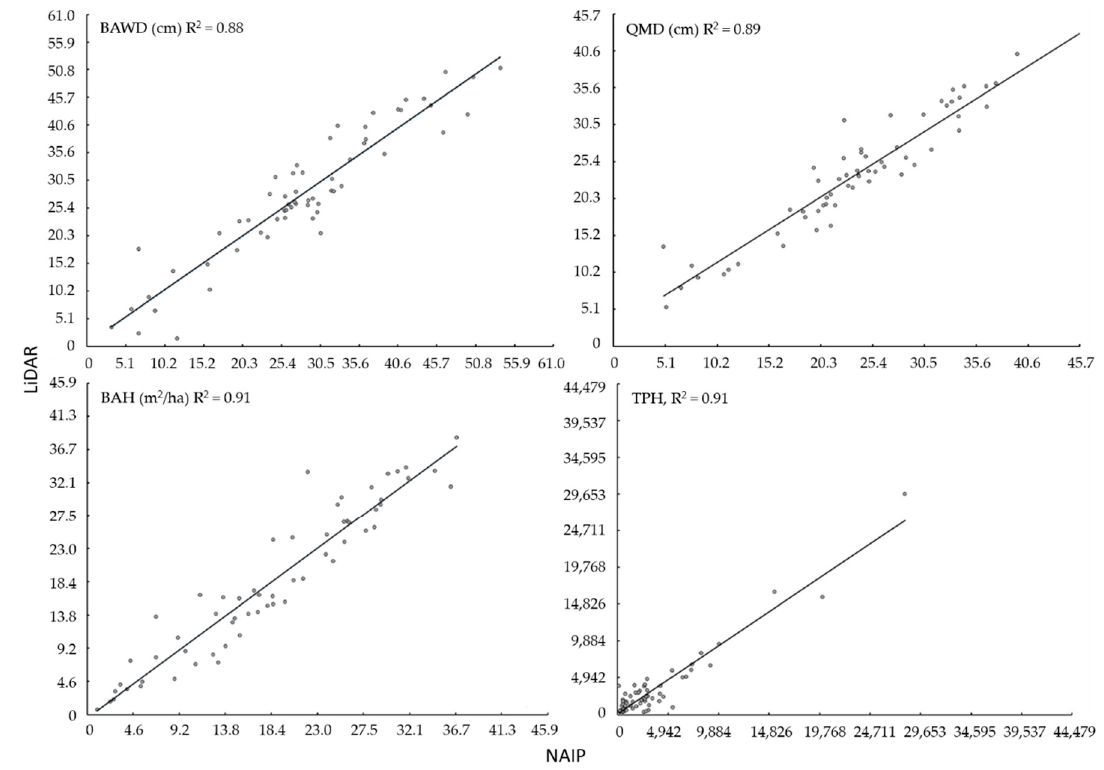
Figure 8. Linear relationship between basal area weighted diameter (BAWD), quadratic mean diameter (QMD), basal area per hectare (BAH), and trees per hectare (TPH) estimates derived from NAIP and LiDAR models (Table 1). Observed versus predicted values for NAIP and LiDAR based BAWD, QMD, BAH, and TPH are given in Figure A2.